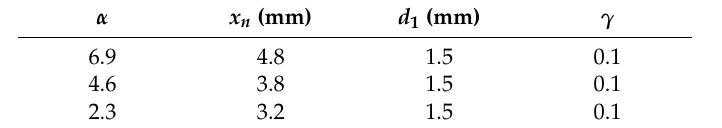
Table 4. Calculated parameters for the high-pressure roll crusher model and the selection function for the PF-1 test. The angles are in degrees and the factor γ is dimensionless.